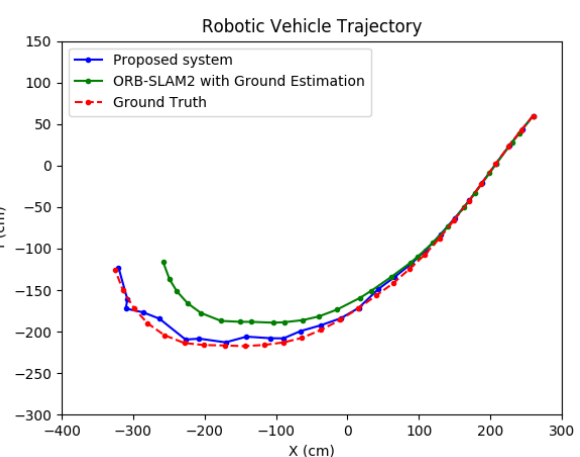
Figure 25. Lab floorplan, see [2].